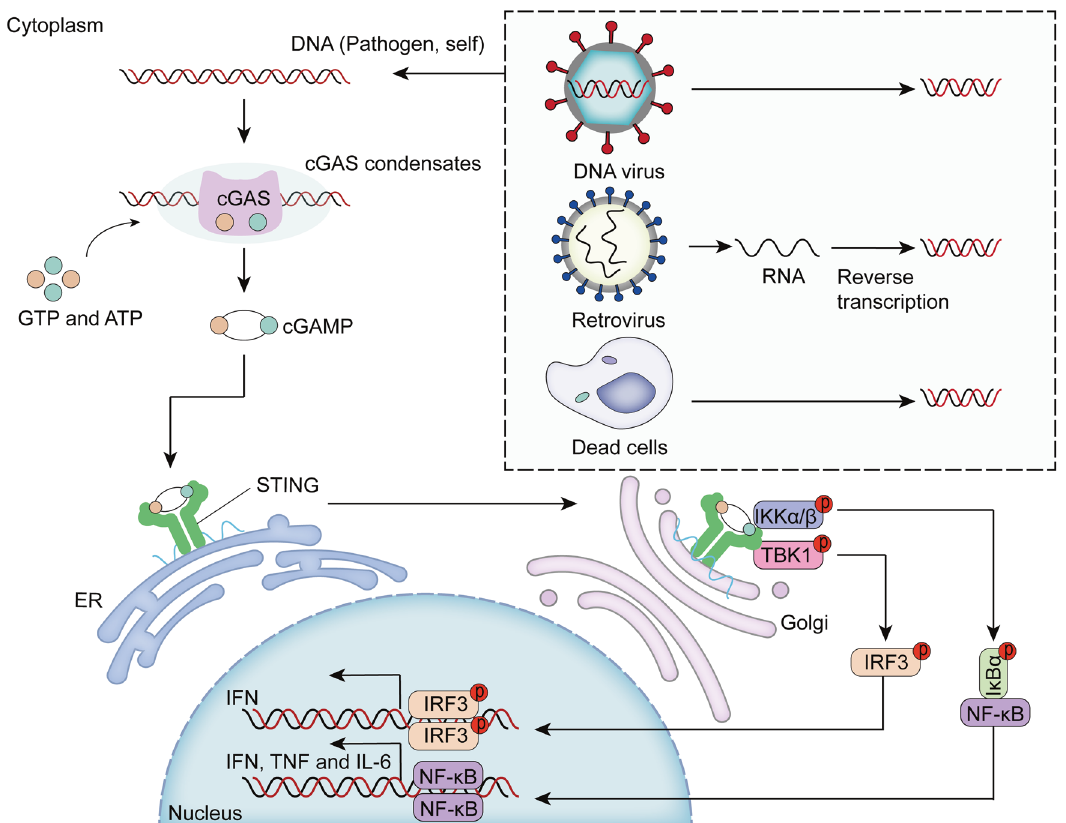
Fig. 4 Phase separation of enzyme cyclic GMP-AMP synthase (cGAS) contributes to innate immunity. The cellular enzyme cGAS directly induces phase separation via binding with DNA and produces cGAMP. cGAMP interacts with STING and activates downstream innate